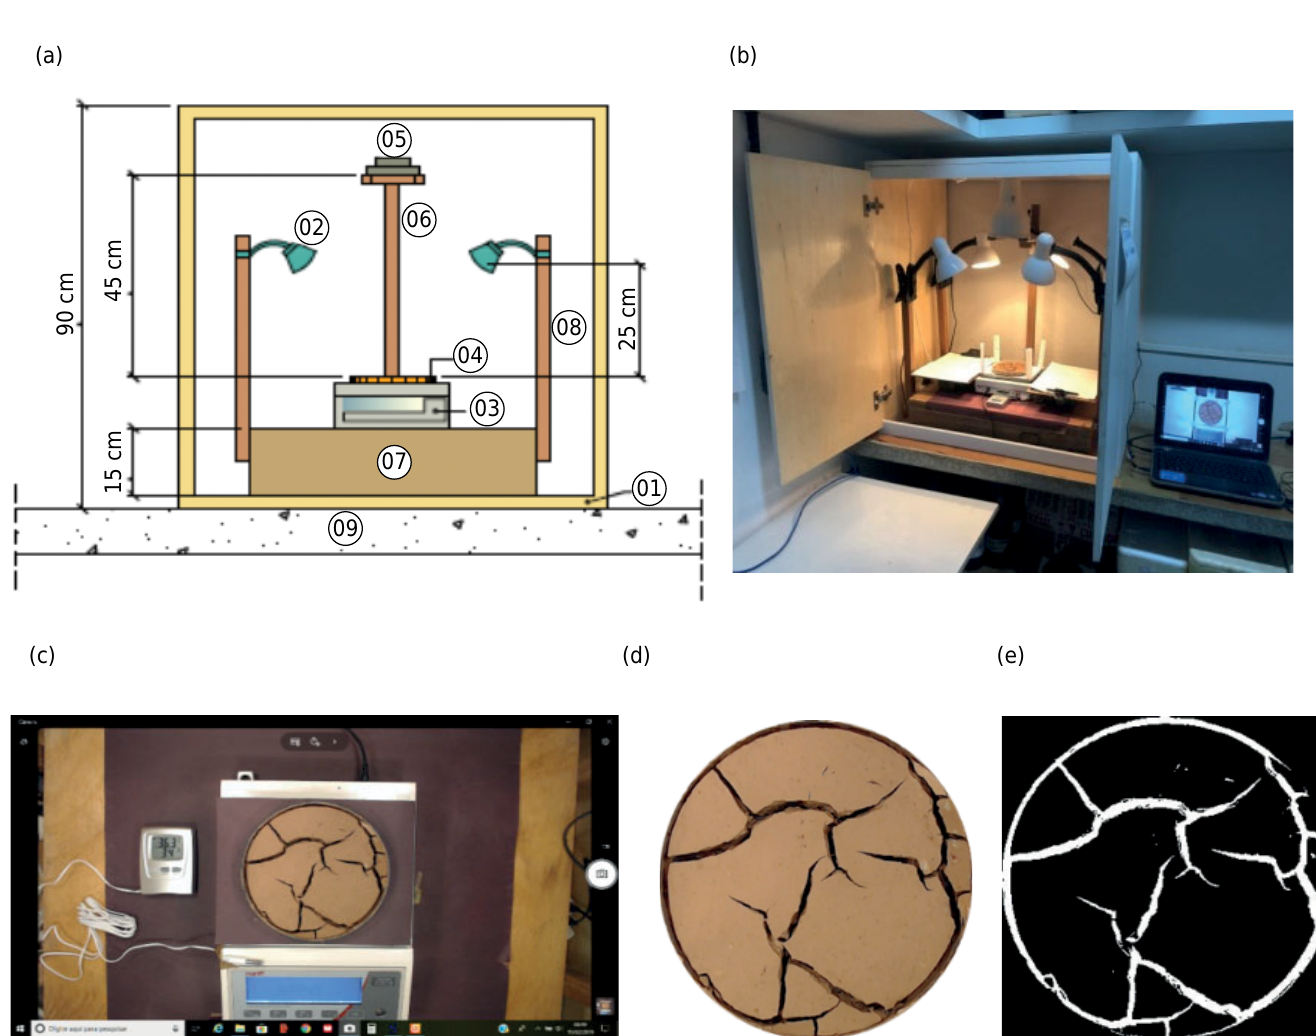
Figure 1. Crack propagation test apparatus. (a) Front view: measures in meters; (b) overview; (c) image selection and cropping process; (d) original color image; (e) binarized image. 01: MDF box; 02: light fixtures; 03: scale with 0.01 g sensitivity; 04: soil-plate Petri assembly; 05: webcam; 06: webcam support rod; 07: wooden base; 08: light fixture support rods; 09: